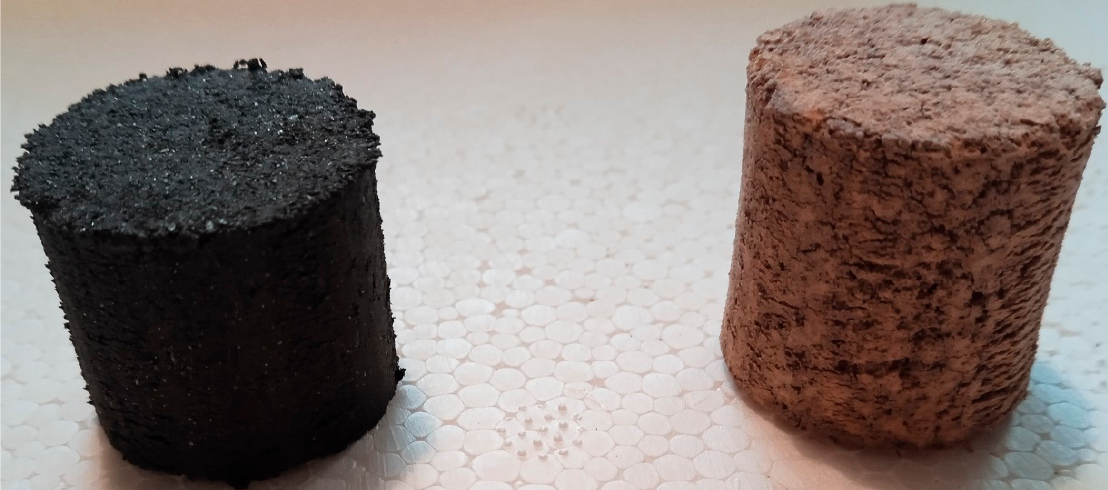
Figure 2. Starting ( left ) and roasted at 1150 °C for 65 min ( right ) compacted samples.